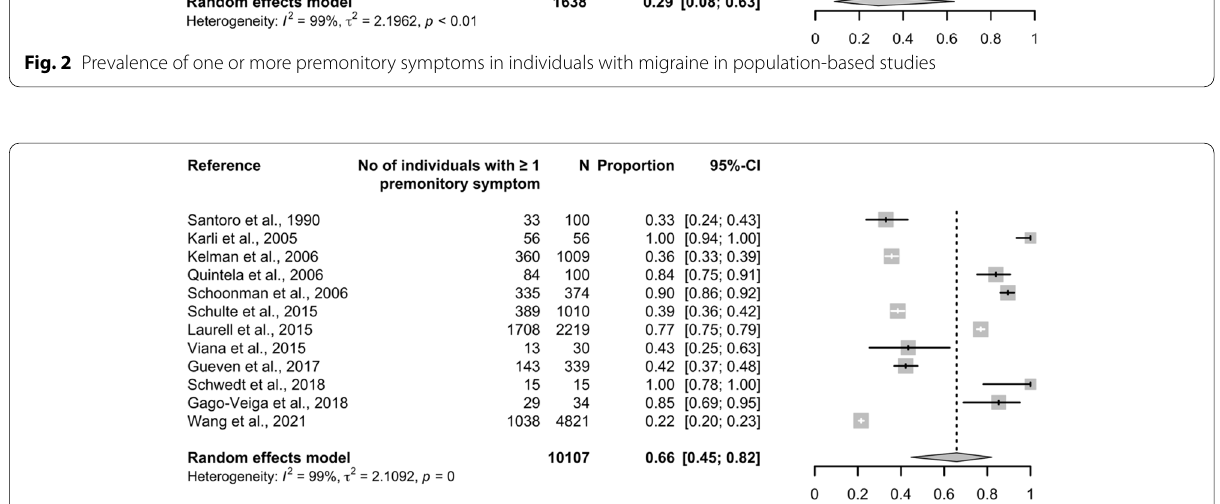
Fig. 3 Relative frequency of one or more premonitory symptoms in individuals with migraine in clinic-based studies.